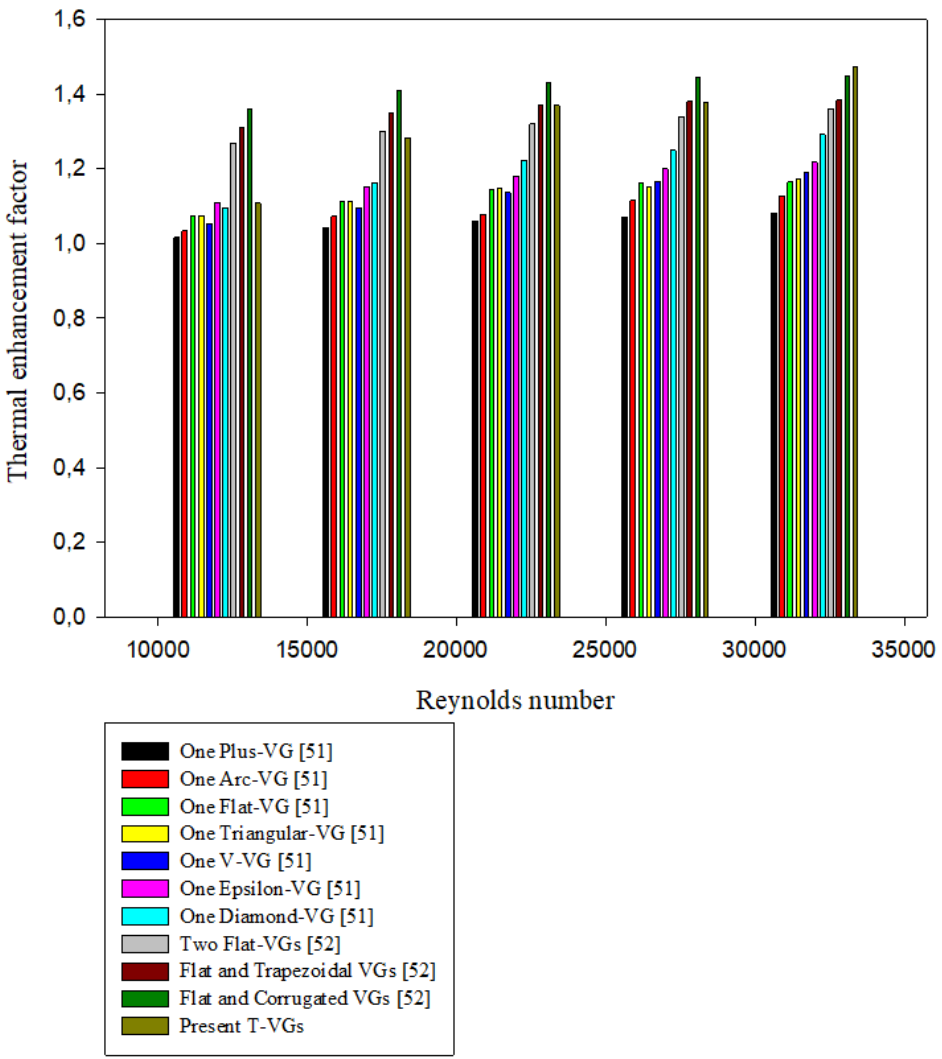
Figure 17. Thermal improvement factor vs. Re.